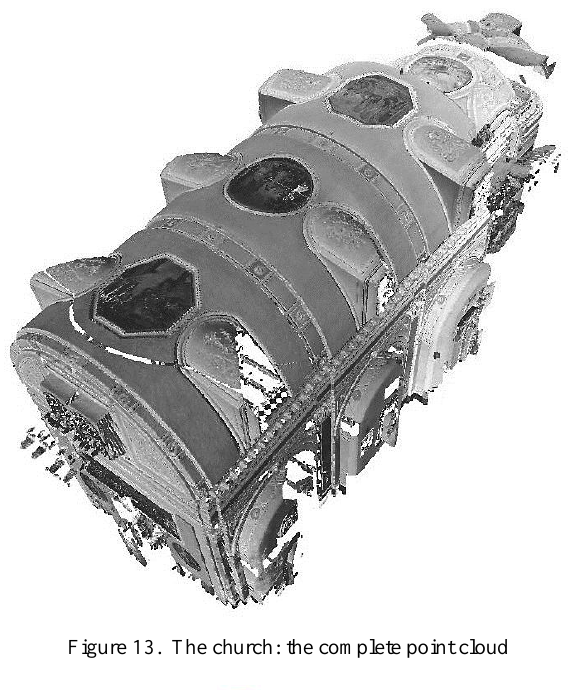
Figure 13. The church: the complete point cloud